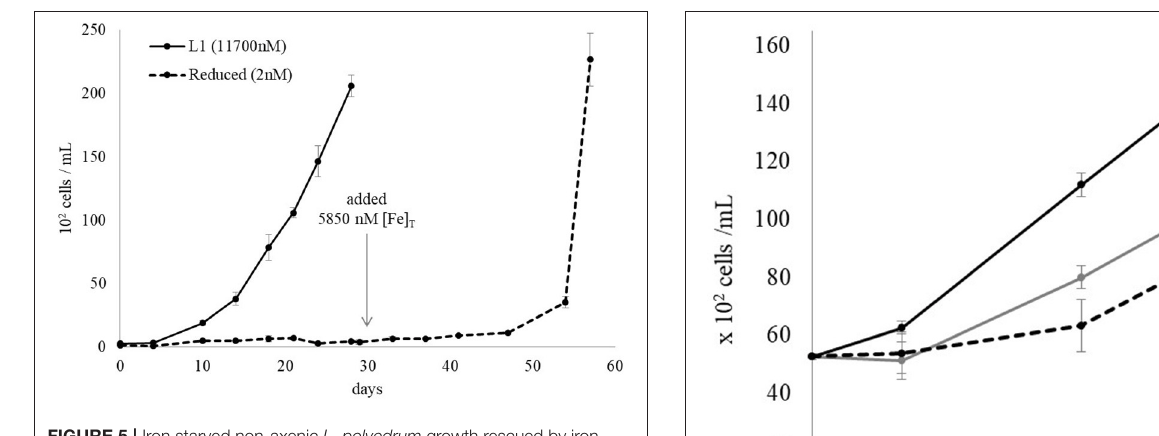
FIGURE 5 | Iron starved non-axenic L. polyedrum growth rescued by iron addition. The iron sufficient culture (solid black line) contained 11,700nM [Fe] T while the iron deficient culture contained 2nM (dotted black line). After 28 days 5,850nM [Fe] T was added to the iron deficient culture which rescued L. polyedrum growth.